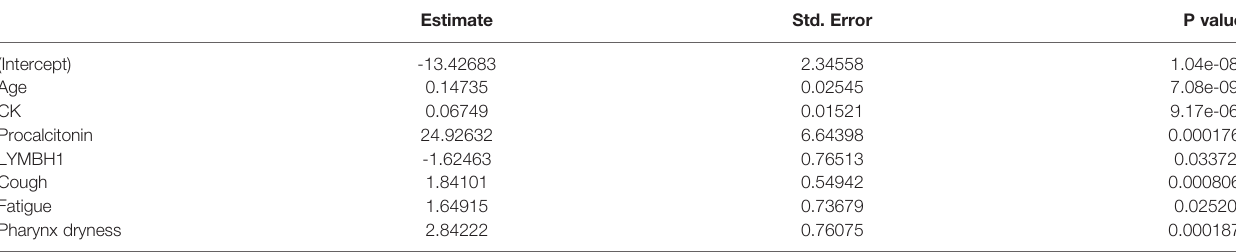
TABLE 4 | Logistics model